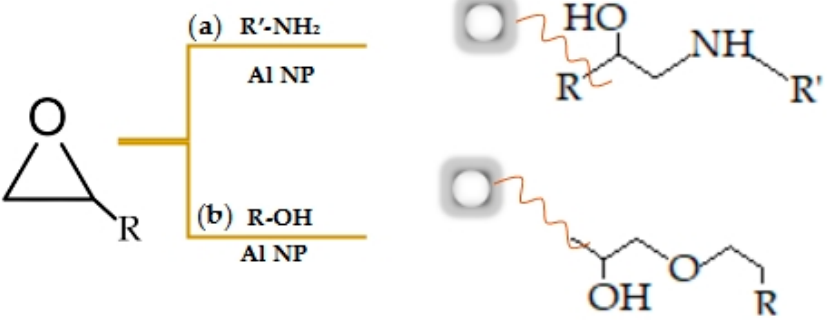
Figure 11 . Possible reactions of incorporation of Al NP ( a ) into the added hardener (amine) and ( b ) directly in the epoxy matrix.